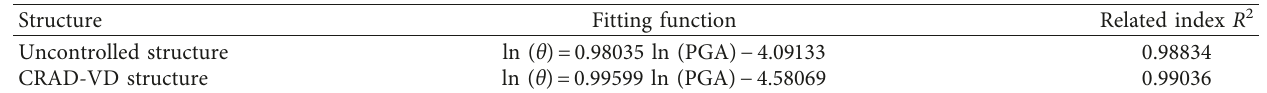
Table 6: Probabilistic seismic demand model.